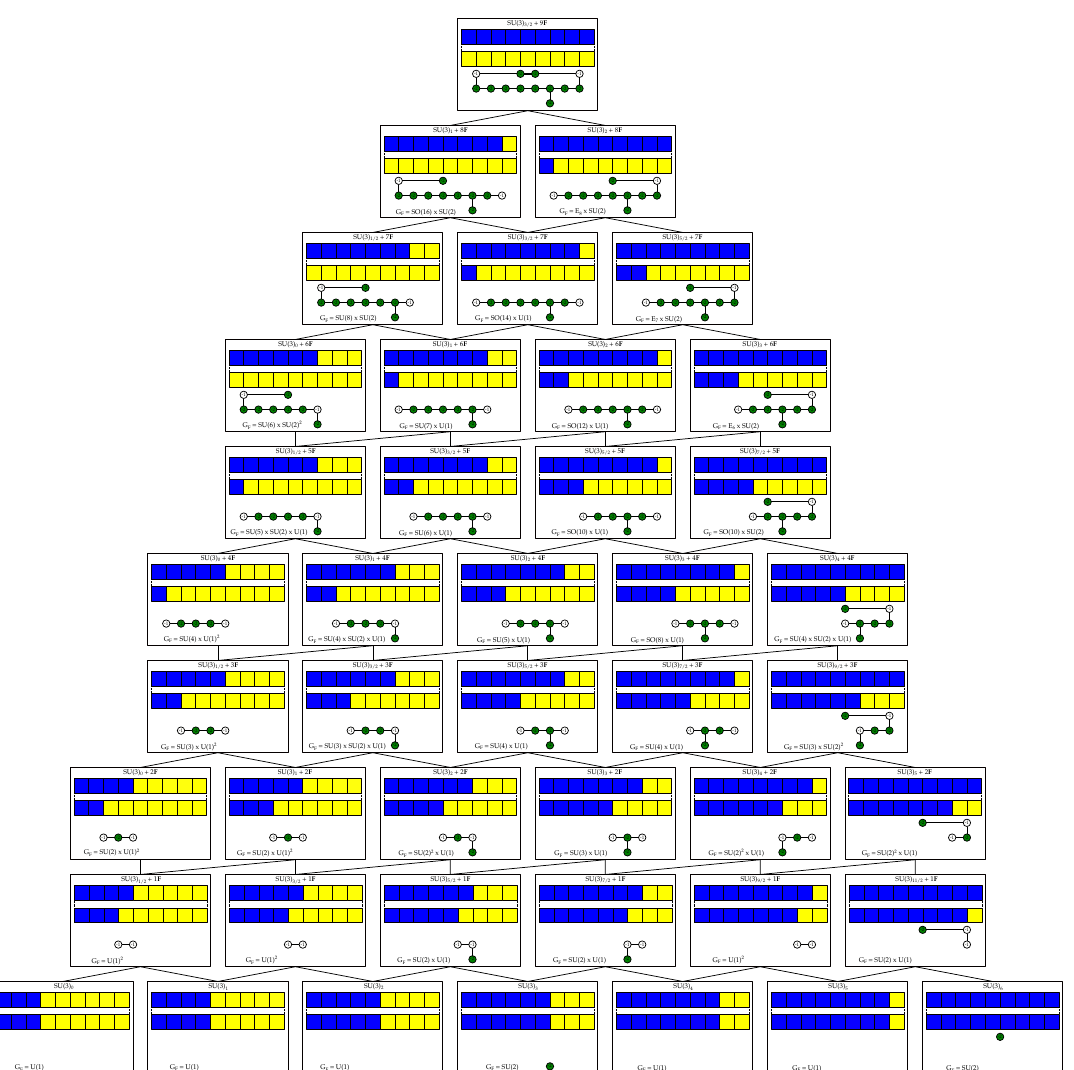
Figure 30. Rank two E-string: the marginal 5d gauge theory description as SU(3) (cid:13)avor-equivalence classes of this marginal theory can be written in terms of box graphs, and each box graph corresponds to a descendant 5d gauge theory. All of the descendant theories have 5d superconformal (cid:12)xed points. Below the box graph equivalence classes we show the reduced CFDs which encode the superconformal (cid:13)avor